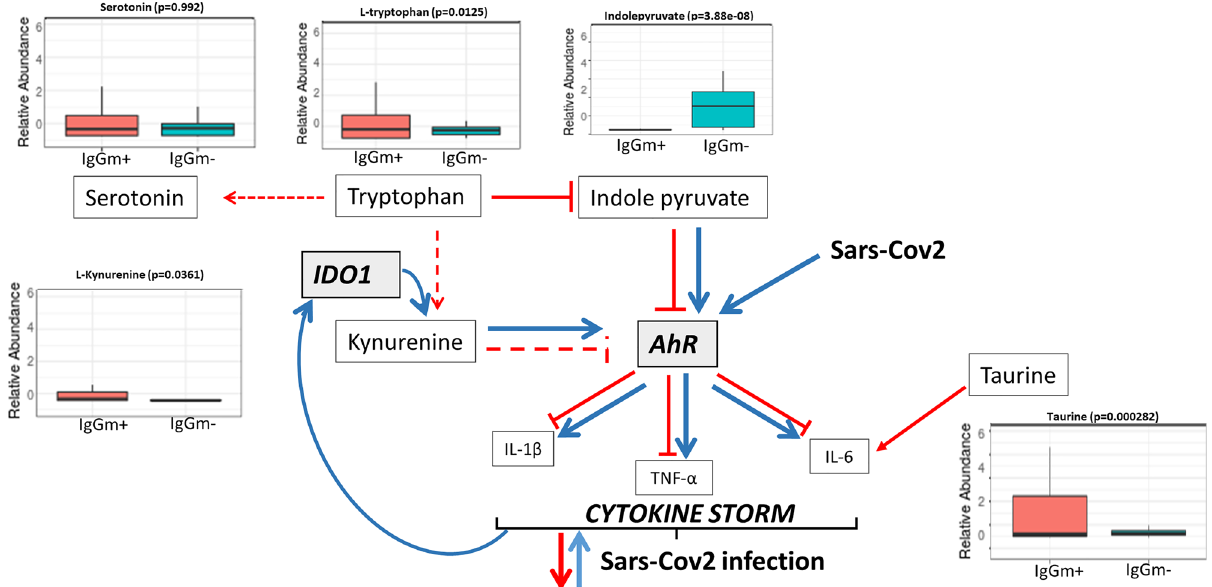
Figure 5. A schematic diagram of tryptophan metabolism, including box plots of quantified metabolites. Data are expressed as the mean and standard deviation (SD) of the normalized peak area. Reduction in the level of indolepyruvate and increase in the level of kynurenine act on AhR signalling pathways contribute to defence against SARS-CoV-2